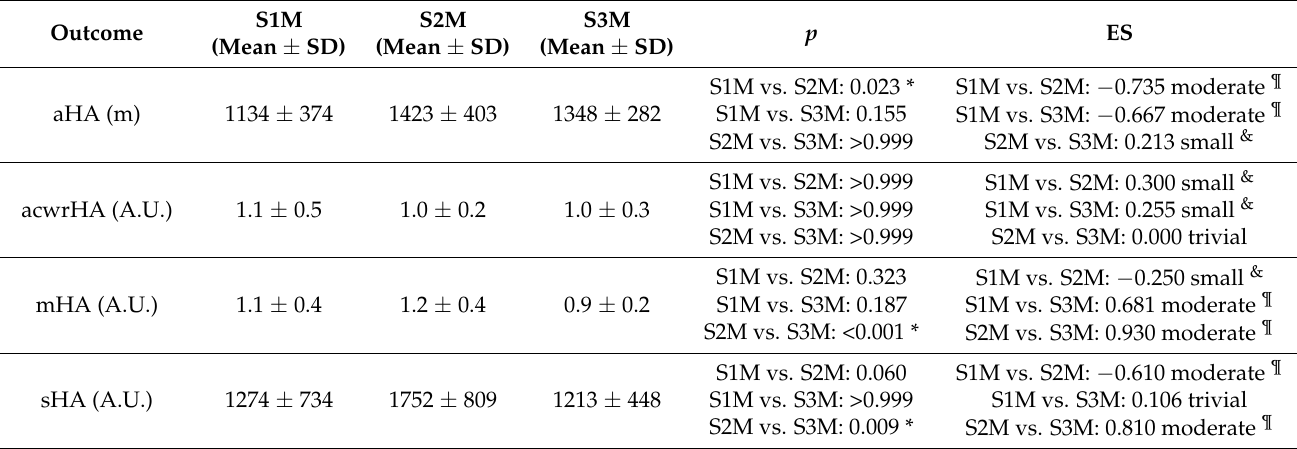
Table 3. Descriptive and inferential statistics (mean ± SD) of high accelerations workload indices in different levels of participation in